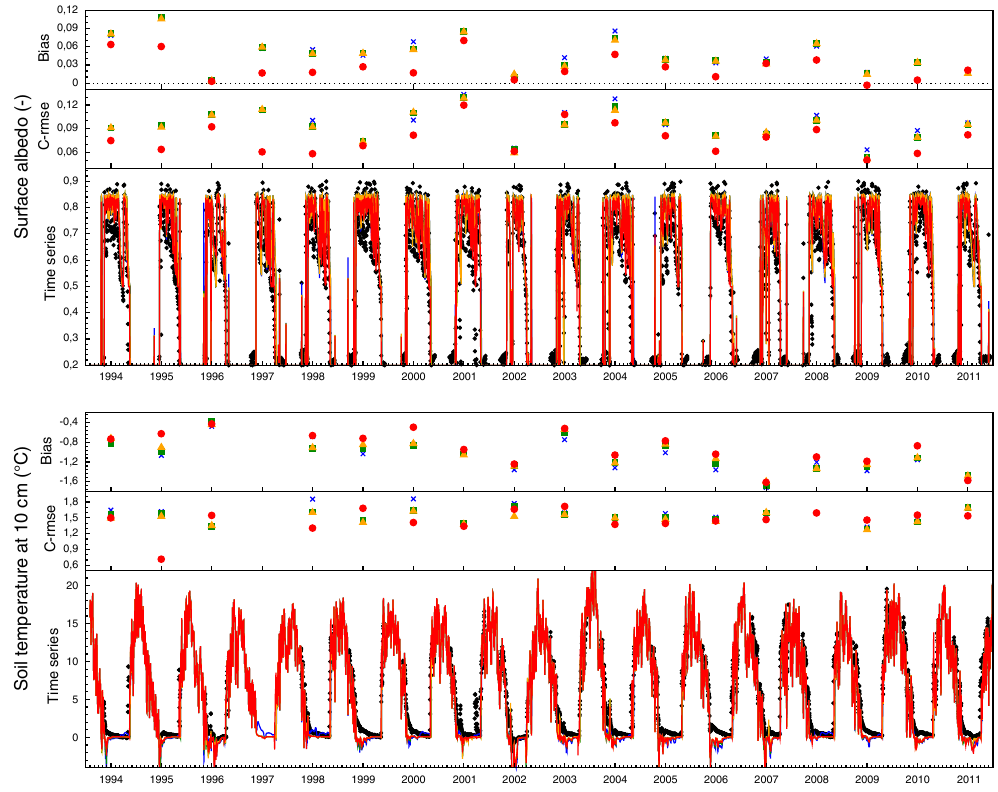
Figure 4. As Fig. 3 but for surface albedo (top panel) and soil temperature at 10cm depth (bottom panel).